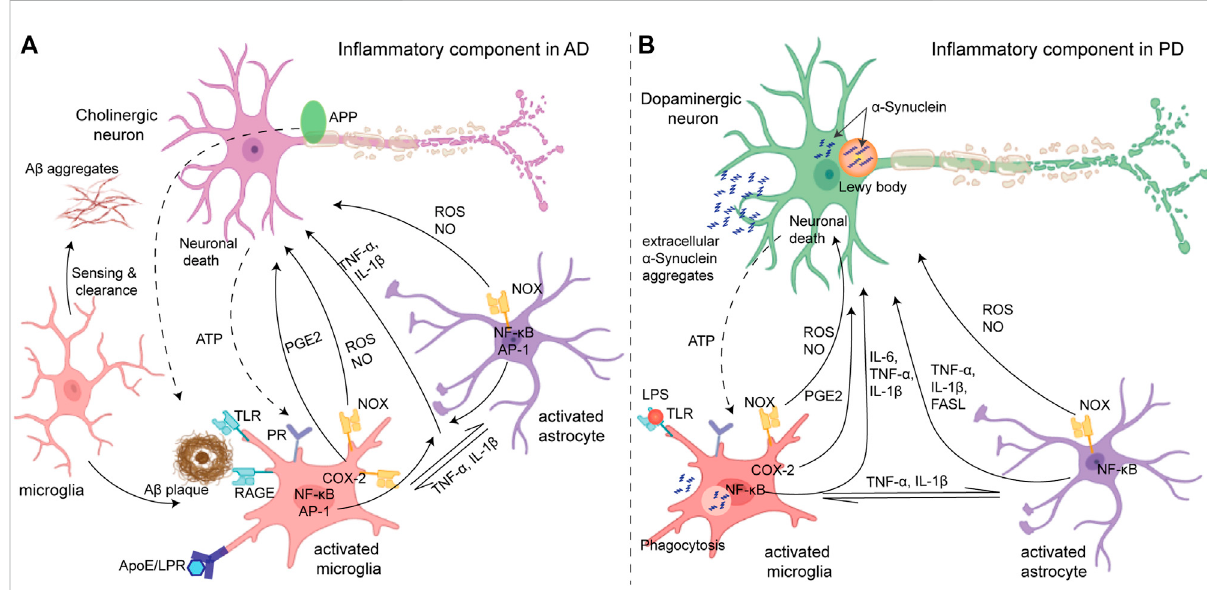
FIGURE 2 (A) In fl ammatory components in Alzheimer ’ s disease (left): initially, microglia act as neuroprotectants that can sense and migrate to the A β aggregates. The A β aggregates interact with different cell surface receptors (TLR and RAGE) of microglia which induce activation of some transcription factors such as NF-kB and AP-1 and produce reactive species (ROS and NO) and cytokines (microglial activation). However, under sustained in fl ammation, activated microglia exhibit compromised A β clearance ability due to impaired ApoE/LRP uptake, while the production of ROS and in fl ammatory mediators remains unaltered which directly causes apoptosis/necrosis in neurons. Activated microglia can also activate astrocytesbyreleasingcytokineswhichinreturncanfurtheractivatethemicroglia.Inaddition,ATPreleasedfromneuronaldeathactivatesmicroglia via the purinergic receptors (PR), and collectively, a feed-forward loop is established. (B) Parkinson ’ s disease (right): intracellular deposition of α - synuclein known as Lewy bodies caused stress in dopaminergic neurons, while the oligomeric α -synuclein in the extracellular space causes activation of glia cells (microglia and astrocytes) in a similar manner to amplify the neuroin fl ammation and oxidative stress causing the death of dopaminergic neurons. Adapted with permission from (Glass et al.,